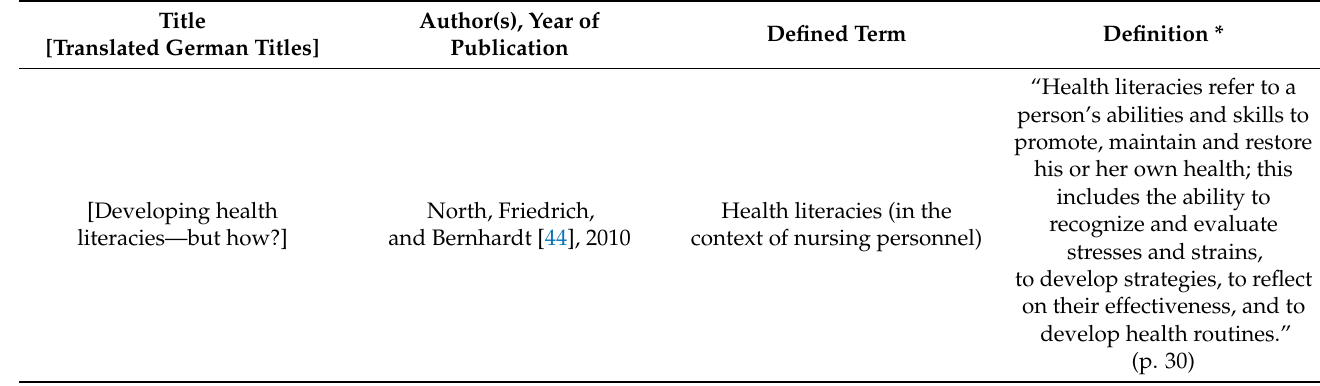
Table 1. Definition of health literacy in the workplace as individual